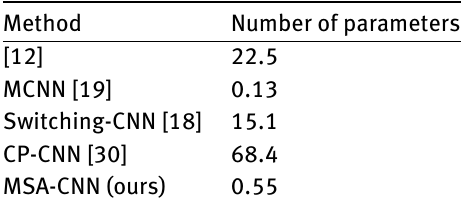
Table 4: Number of parameters(in